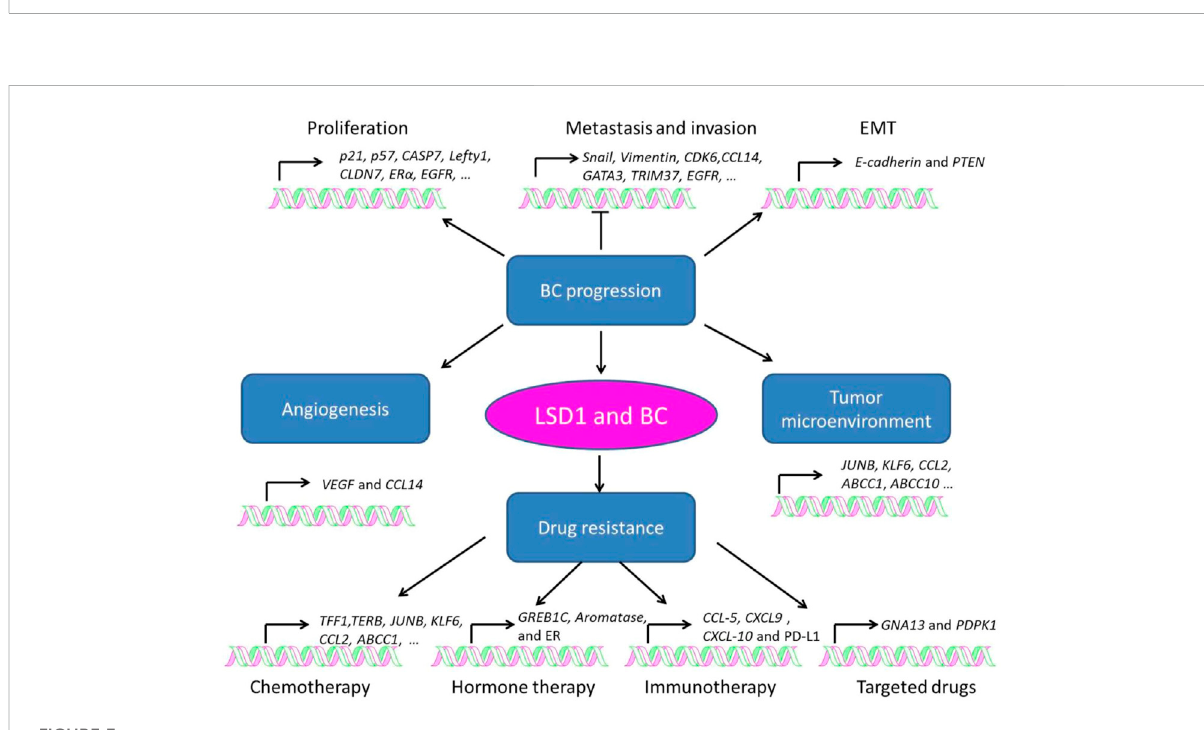
FIGURE 3 Role of LSD1 in breast cancer progression, angiogenesis, tumor microenvironment, and drug